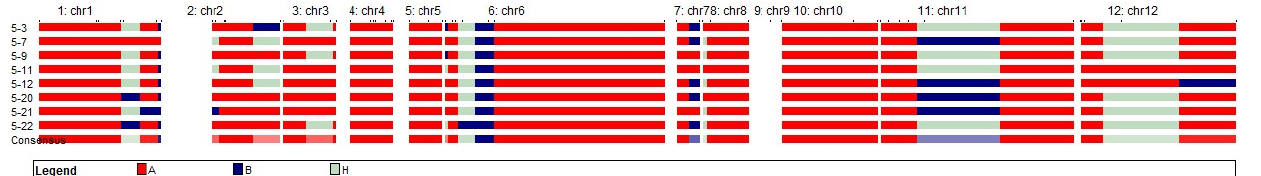
Figure 3. Graphical genotyping of the advanced backcross lines. The red color indicates the homozygous regions for CO 51 (recurrent parent). The blue color indicates the homozygous regions for 562-4 (donor parent) and the light green color indicates the heterozygous regions.